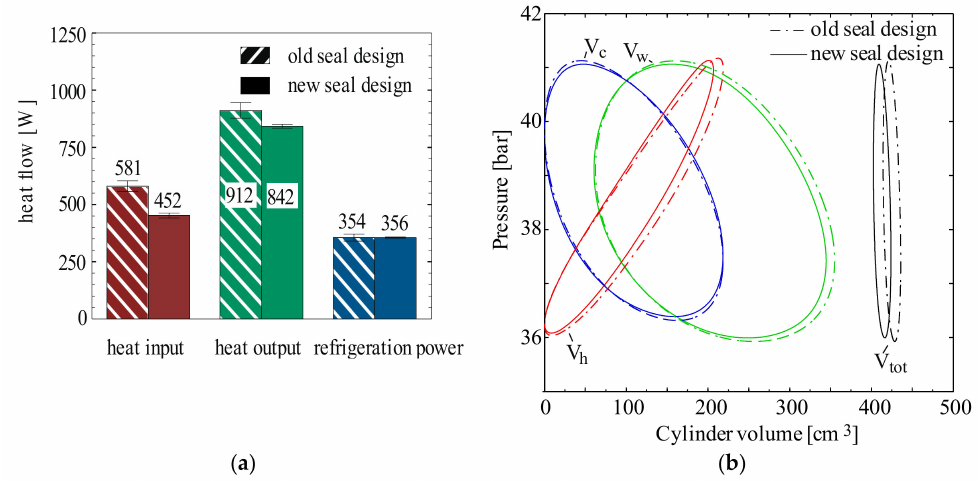
Figure 3. Experimental heat input, heat output and refrigeration power: ( a ) and p,V-plots ( b ) in Vuilleumier mode with new and old seal design at nominal